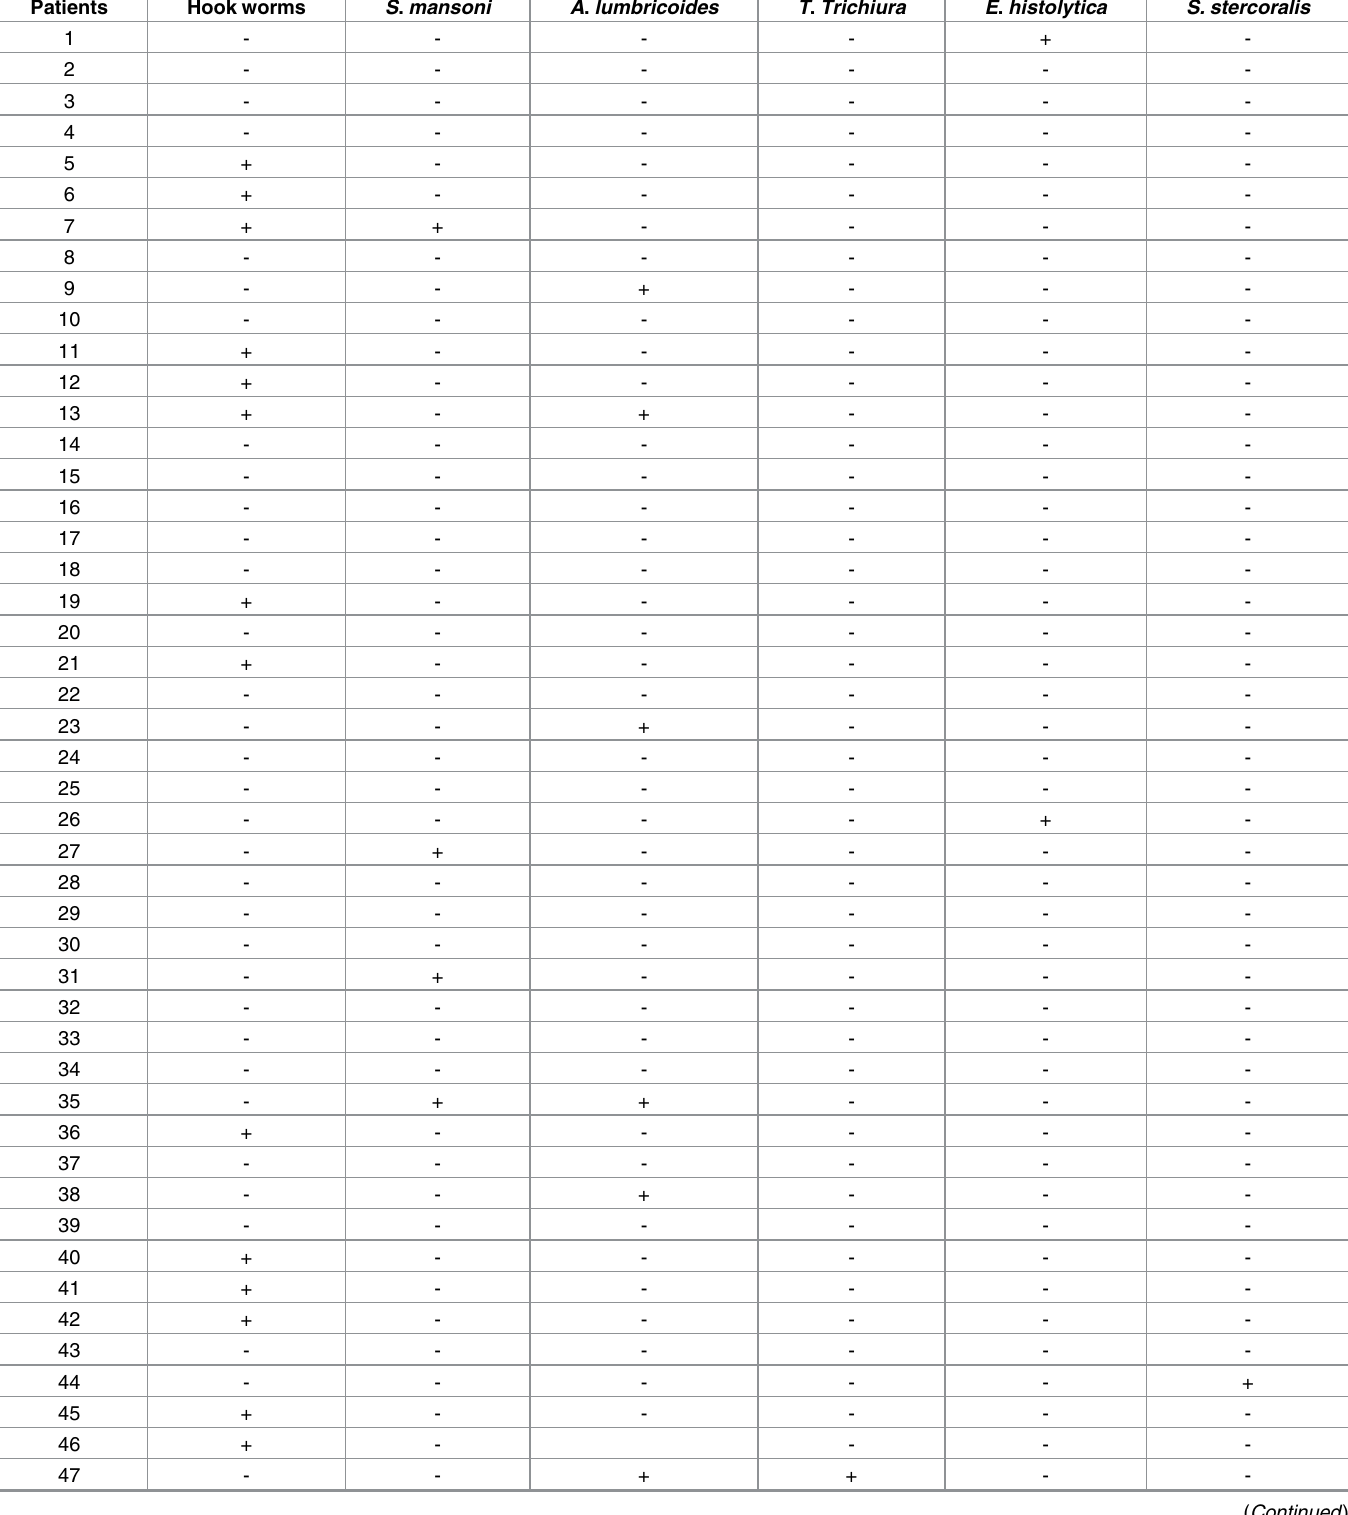
Table 2. Intestinal parasite distribution amongst VL patients. Patients Hook